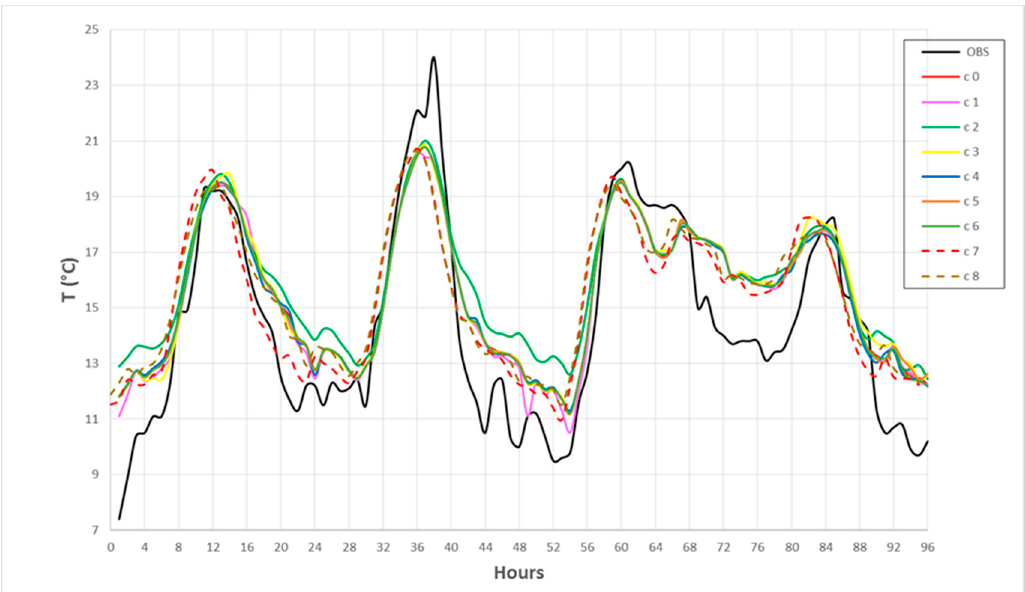
Figure 2. Time series of T2m (°C) at the CIRA site for event 3–6 November 2017: observational and model data for reference configuration and sensitive configurations from c1 to c8.